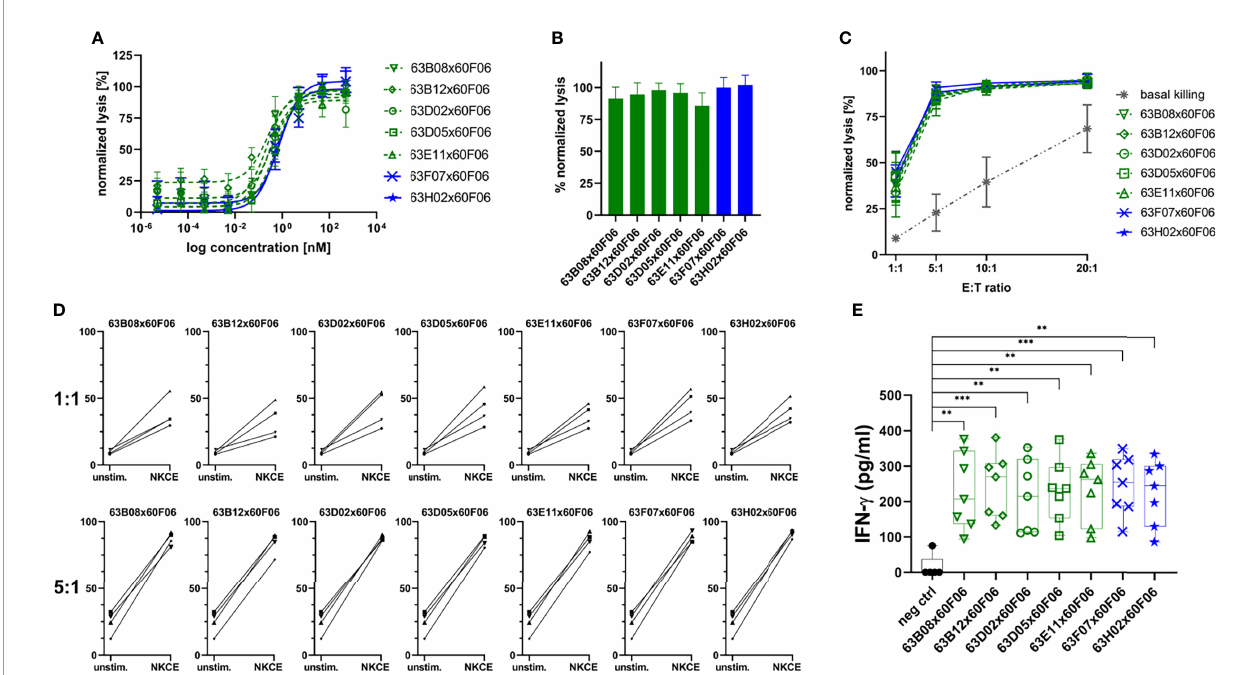
FIGURE 5 | Characterization of selected cattle-derived ultralong CDR-H3 common light chain bsAbs in terms of killing capacities and cytokine release. Fluorescence- microscopy based killing assay using EGFR-positive A431 target cells and PBMC-puri fi ed NK effector cells at an E:T ratio of 5:1. Analysis of dose-dependent (A) and maximum (B) target cell killing. B7H6 competitors shown in green, B7-H6 non competitors given in blue. Data was normalized to allow comparison of the independent experiments. Graphs show normalized means ± SEM of n = 8 different healthy donors. (C) Maximum killing capacities at different effector to target (E:T) ratios. Cattle derived common light chain bsAbs were applied at a concentration of 50 nM. Grey: basal killing activities of NK cells i.e. without addition of bsabs. Data was normalized to allow comparison of the independent experiments. Graphs show normalized means ± SEM of n = 3-4 different healthy donors. (D) Donor speci fi c lysis capacities at an E:T ratio of 1:1 and 5:1. BsAbs were added at 50 nM (NKCE). Unstim: Basal killing of NK cells in the absence of bsAbs. Data was normalized to allow comparison of the independent experiments. Graphs show normalized means ± SEM of n = 4 different healthy donors. (E) NK cell-mediated IFN- g using cytokine HTRF kits for quanti fi cation. Puri fi ed NK cells were co-cultured with A431 cells for 24 h at an E:T ratio of 5:1 prior to analysis. Graphs show box and whisker plots as superimposition with dot plots of 7 individual experiments. *** p ≤ 0.001, ** p ≤ 0.01. B7-H6 competing molecules shown in green, molecules targeting another epitope on NKp30 given in